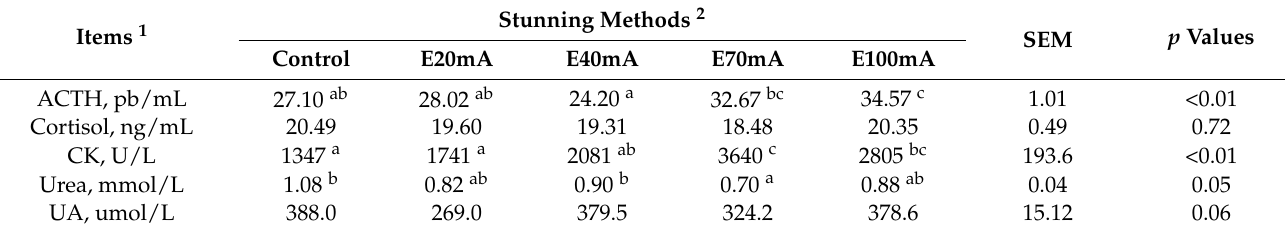
Table 2. Effects of electrical current intensities on serum variables in geese.